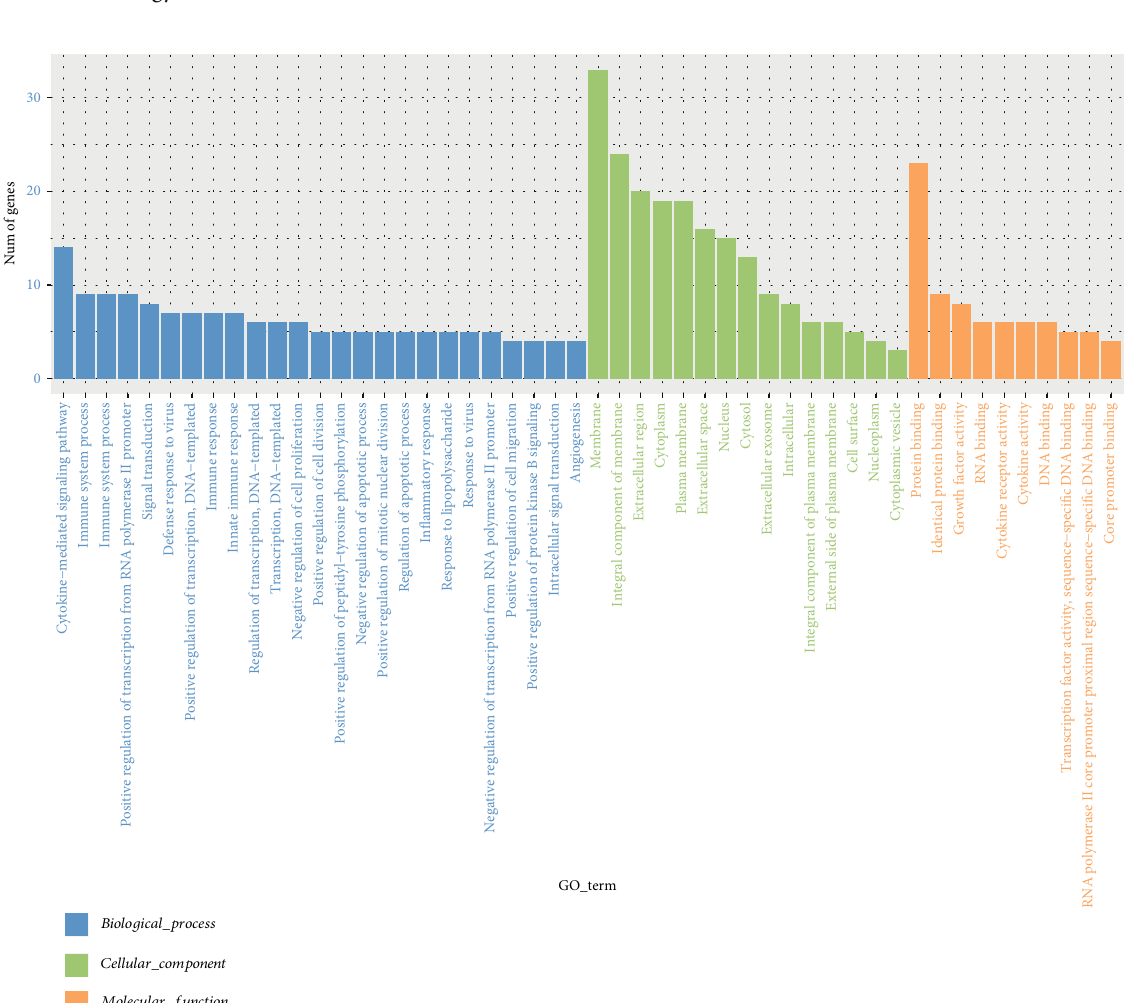
Figure 4: The number and distribution of di ff erent genes in GO